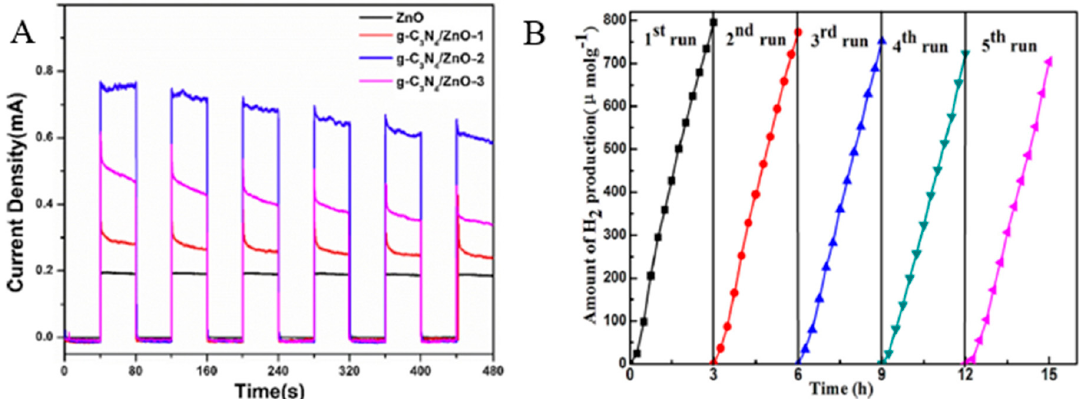
Figure 9. ( A ) Photocurrent response of ZnO/g-C 3 N 4 composite. Reprinted from reference [71].